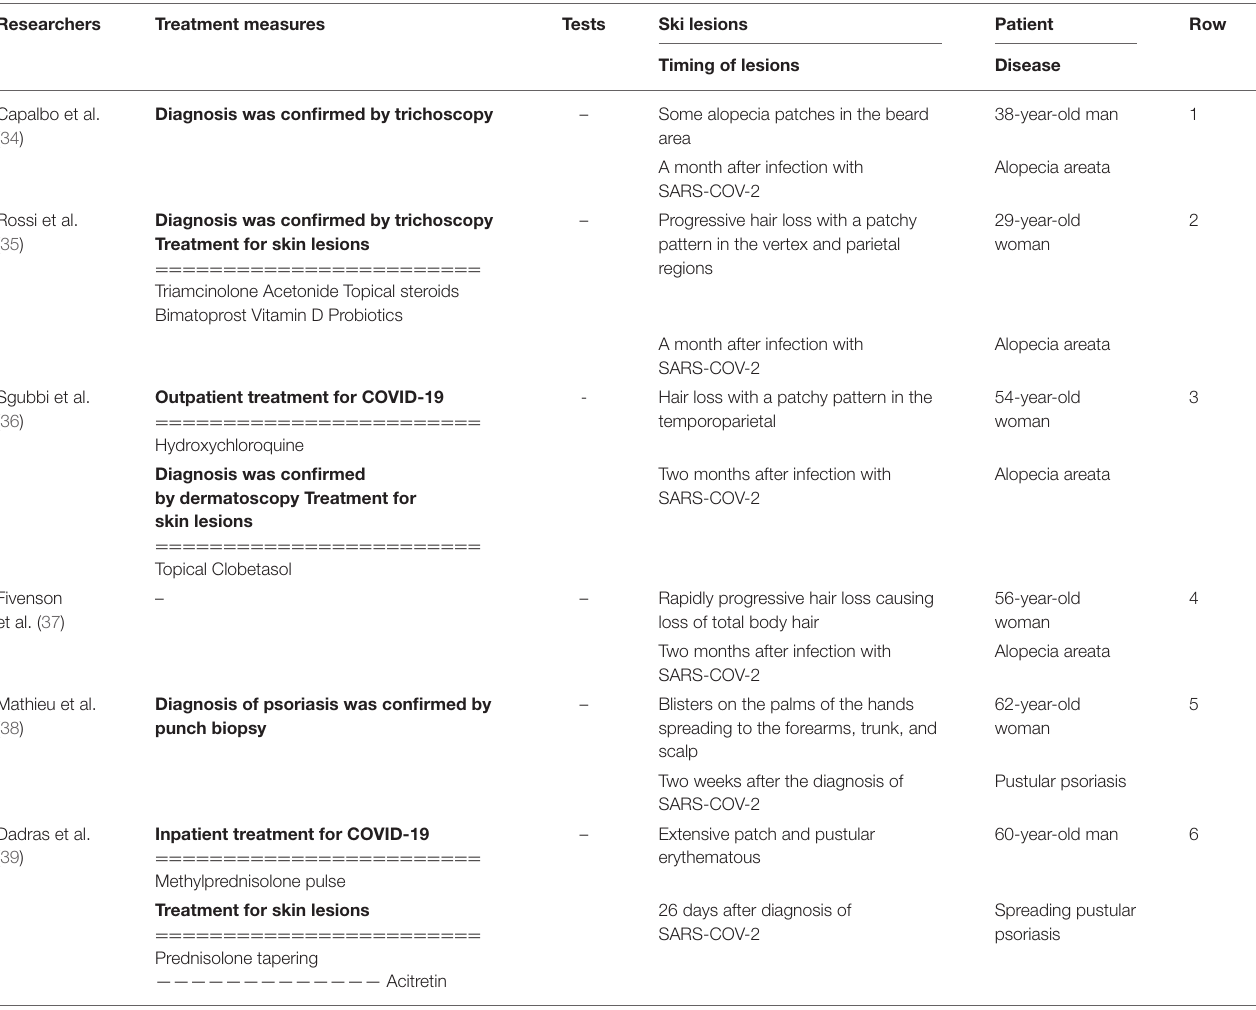
TABLE 3 | Other COVID-19-induced skin